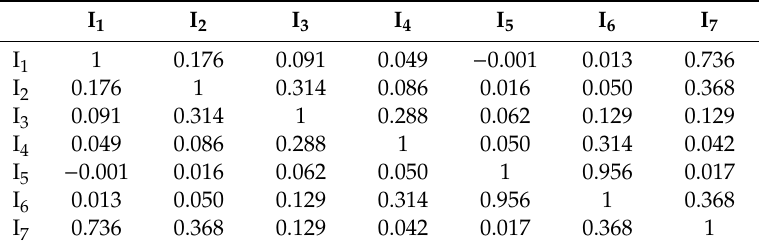
Table 3. Example of item-item similarity with time-related correlation